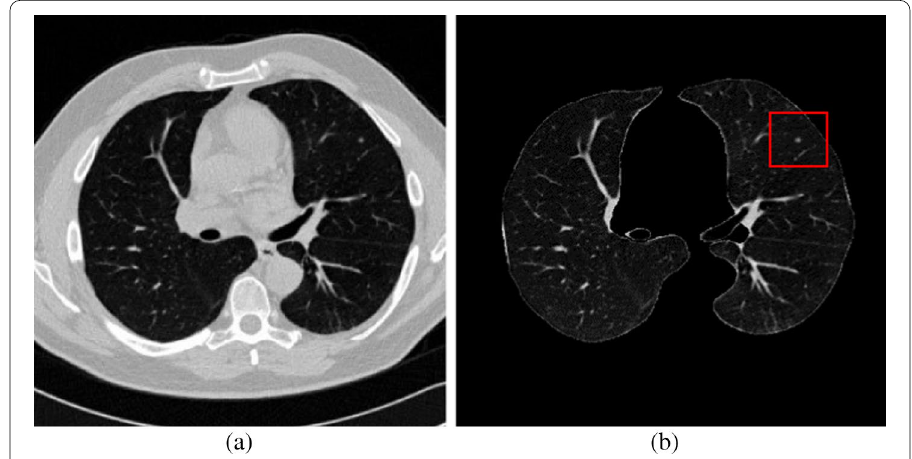
Fig. 2 a Lung CT image; b lung parenchyma image. Lung parenchyma image is extracted from CT image in preprocessing